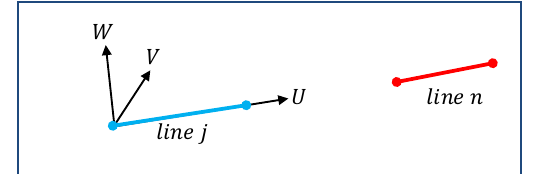
Figure 5. Local coordinate system (U, V, W) definition for line